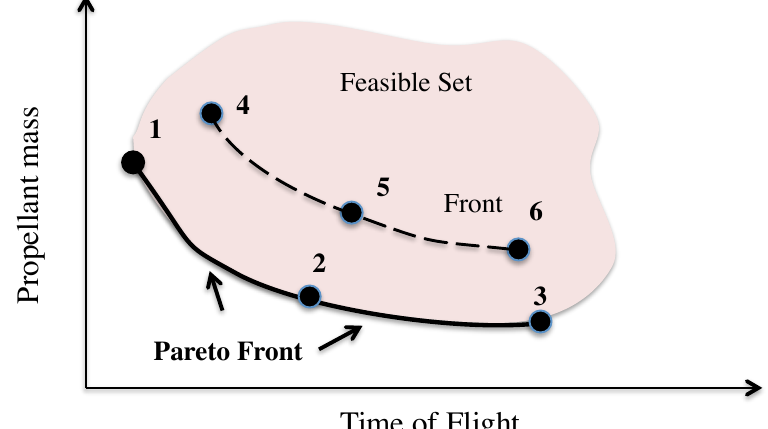
Figure 5. Illustration of a Pareto